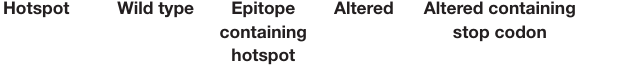
TABLE 1 | Continued Hotspot Epitope